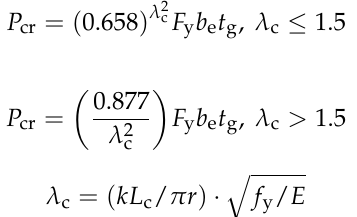
free-edge stiffeners, and k = 2 or 1.2 when the gusset plate is susceptible to out-of-plane of the lengths L 1 , L 2 or L 3 , as presented in Figure 5.